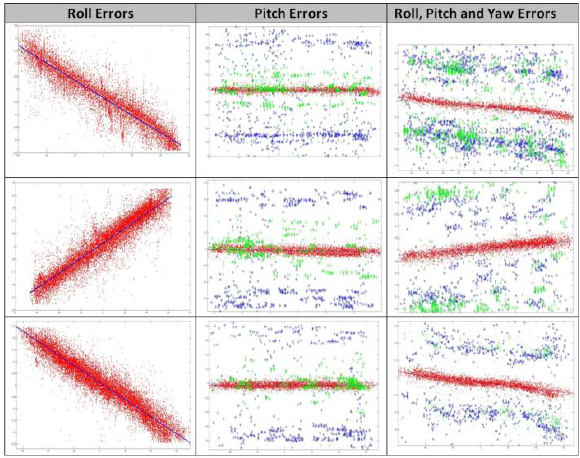
Figure 7 DQM errors as function of distance of points from center of the overlap (each column has different scales). The blue line is a regression fit on the error as function of distance from center of overlap distance of sample measurements from centerline of